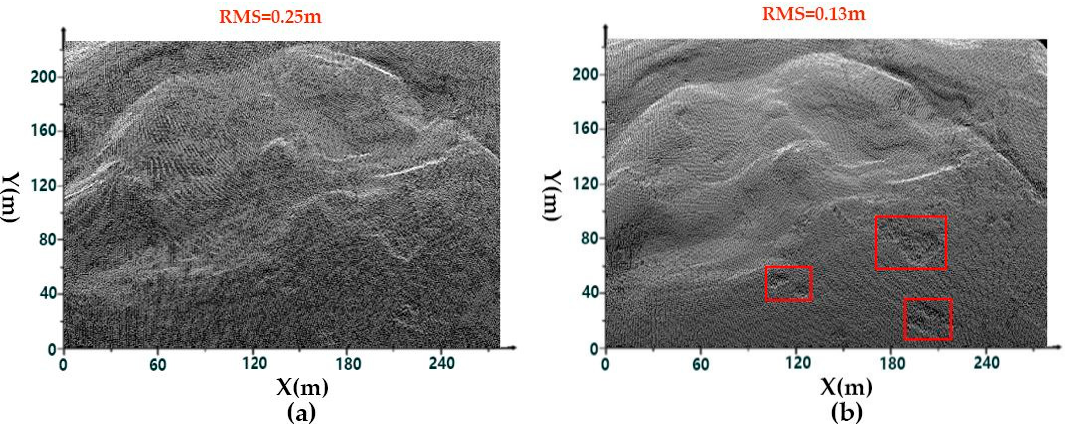
Figure 5. Validation verification of the ICP algorithm. ( a , b ) Terrain feature comparison of overlapped point clouds in region C before and after registration, respectively. The areas in red rectangles are used to show the significant terrain features.